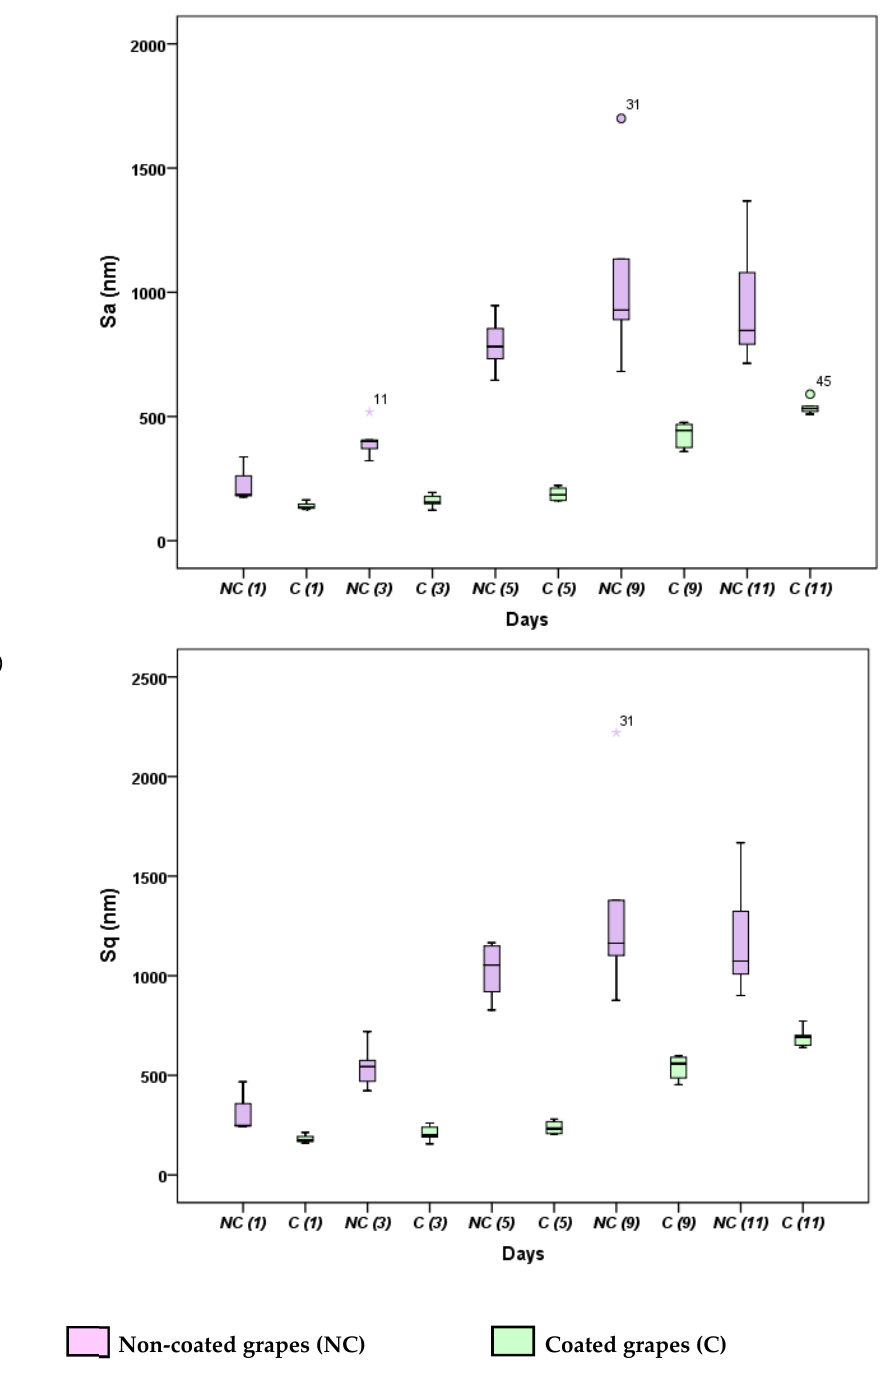
Figure 4. Statistical analysis of Sa ( a ) and Sq ( b ), only considering fine structure, for non-coated and coated grapes after 11 days of storage represented by boxplots.